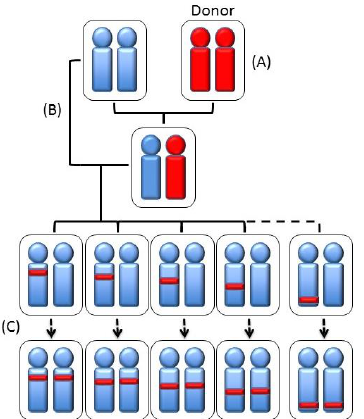
Figure 1. Schematic representation of the generation of recombinant congenic strains. ( A ) A donor inbred strain is selected to be crossed ( B ) with another inbred strain. The descendent is back-crossed, for 5–10 generations, with the recipient strain ( C ). Prior to each back-cross, a selection of the genotype is performed in order to pass a defined chromosomal region from the donor to the recipient strain.